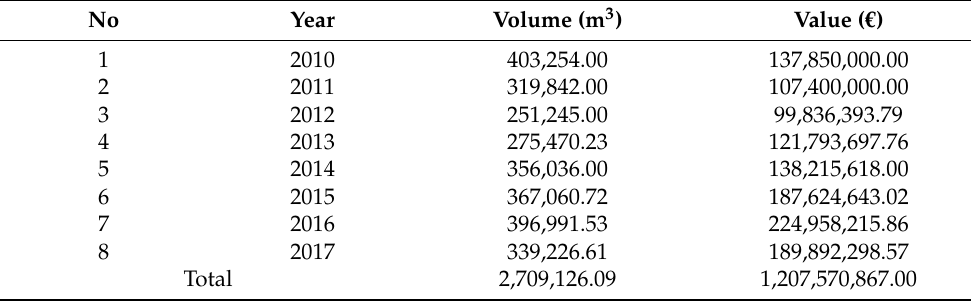
Table 3. Earned foreign exchange from the export of timber and other wood